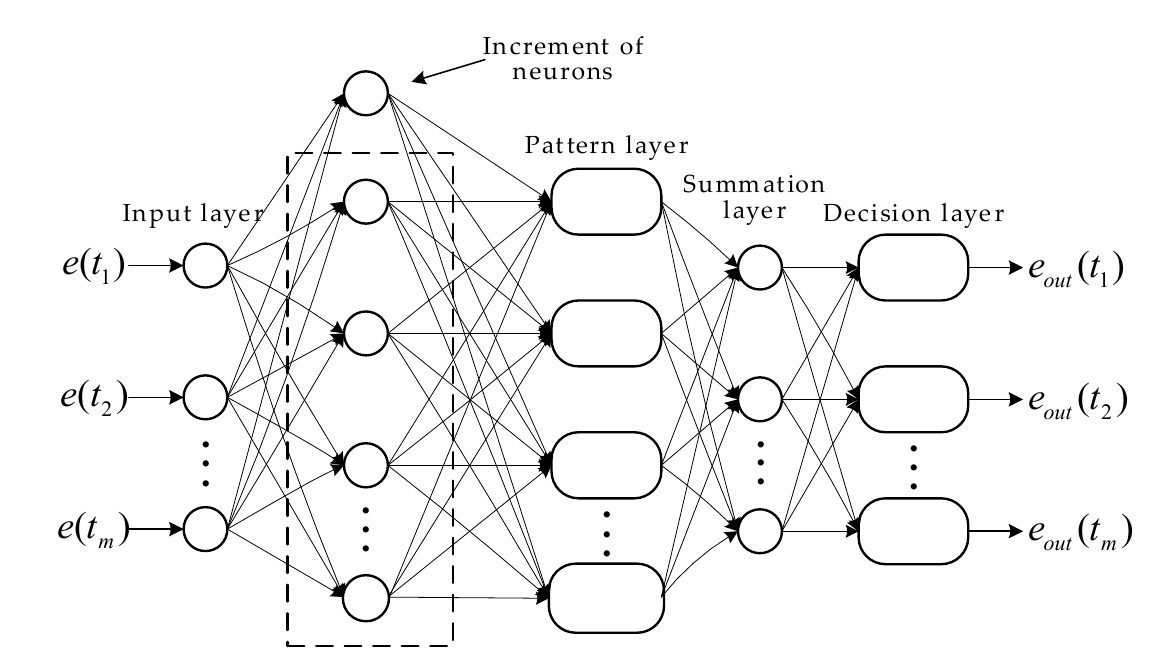
Figure 5. The network structure of IPNN.